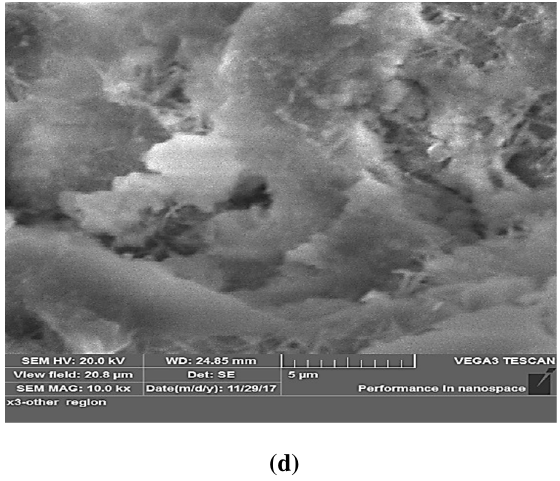
Fig. 1. SEM micrographs of used a: nanoanatase TiO 2 , b: Mortar without addition, in c: Mortar with 0.25 TiO 2 , in d: Mortar with 1% TiO 2